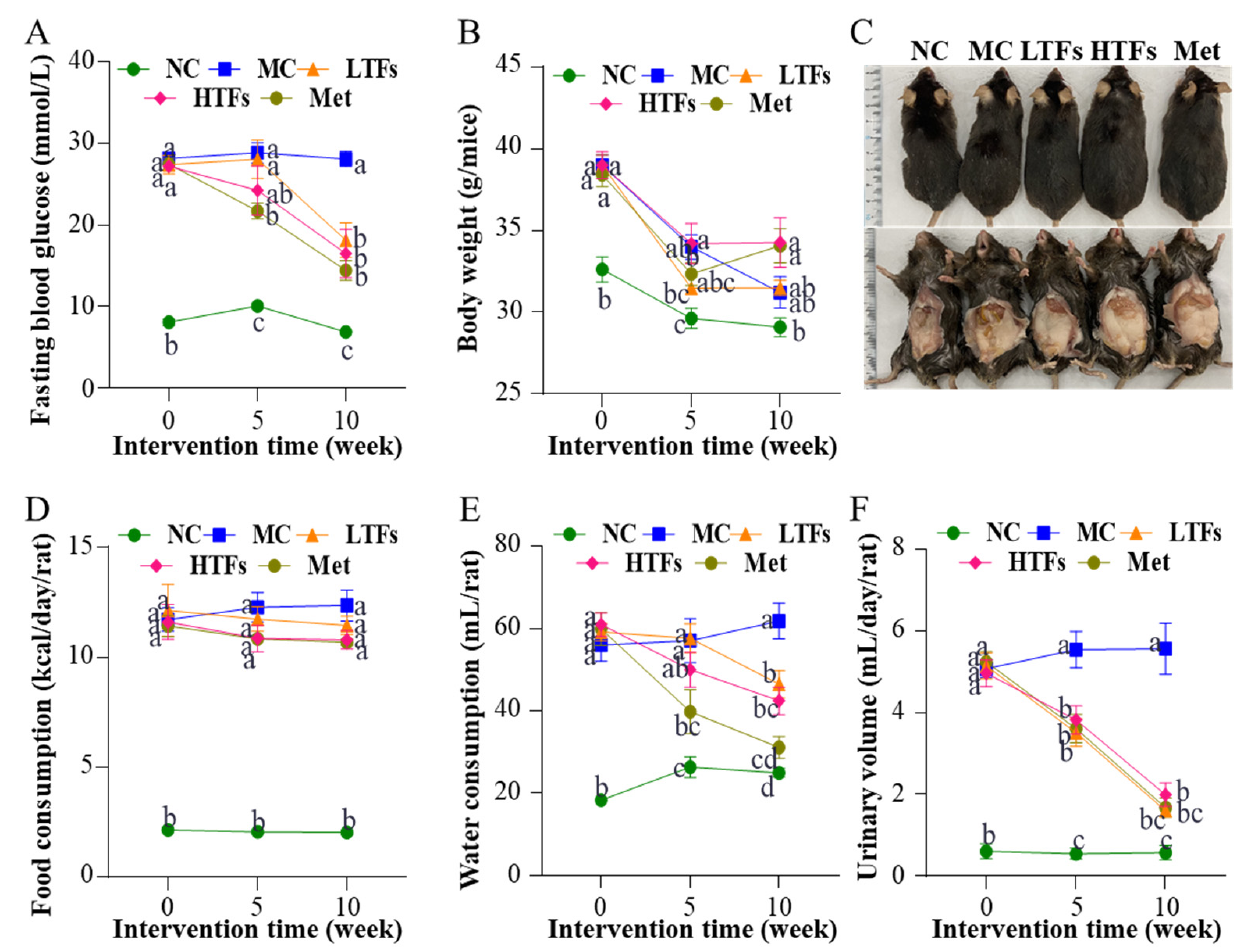
Figure 1. Changes in fasting blood glucose, body weight, food consumption, water consumption, and urinary volume in T2DM mice. Changes in fasting blood glucose ( A ), body weight ( B ), body and abdominal fat ( C ), food consumption ( D ), water consumption ( E ), and urinary volume ( F ). NC: normal control; MC: diabetic model control; LTFs: low-dose TFs; HTFs: high-dose TFs; Met: metfor- min. Each value represents the mean ± SEM ( n = 10). Values at the same column with different letters (a − d) di ff er from each other signi fi cantly ( p < 0.05).